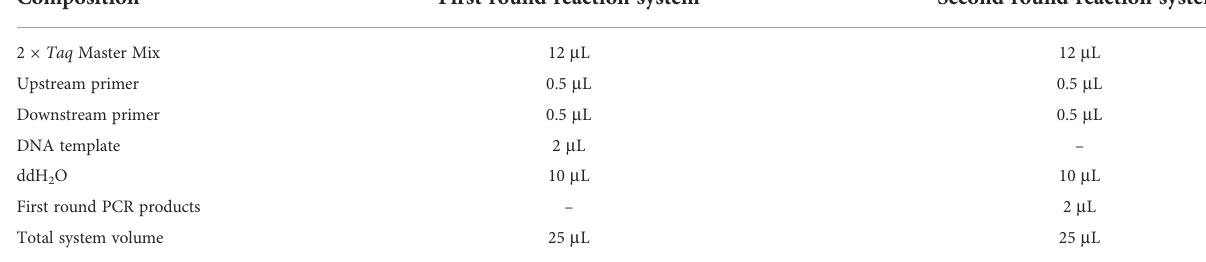
TABLE 3 Nested PCR